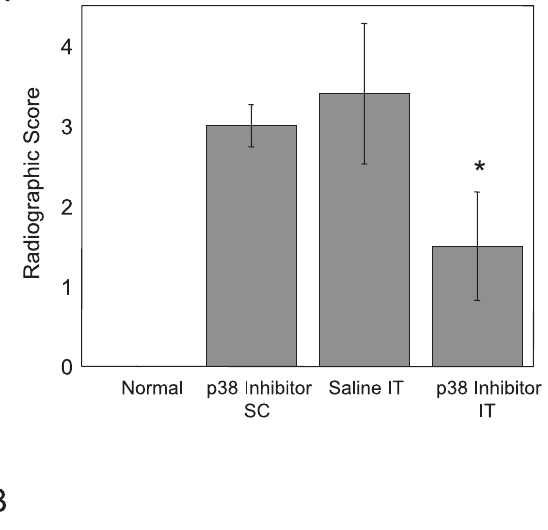
Figure 3. Effect of IT p38 Inhibitor on Joint Damage and Gene Expression in Adjuvant Arthritis Rats were immunized with CFA on day 0 and treated daily with IT SB203580 (8 l g) or IT saline beginning on days 8–20. (A) Radiographs of the hind paws were evaluated using a scoring system that demonstrated decreased damage in the SB203580-treated